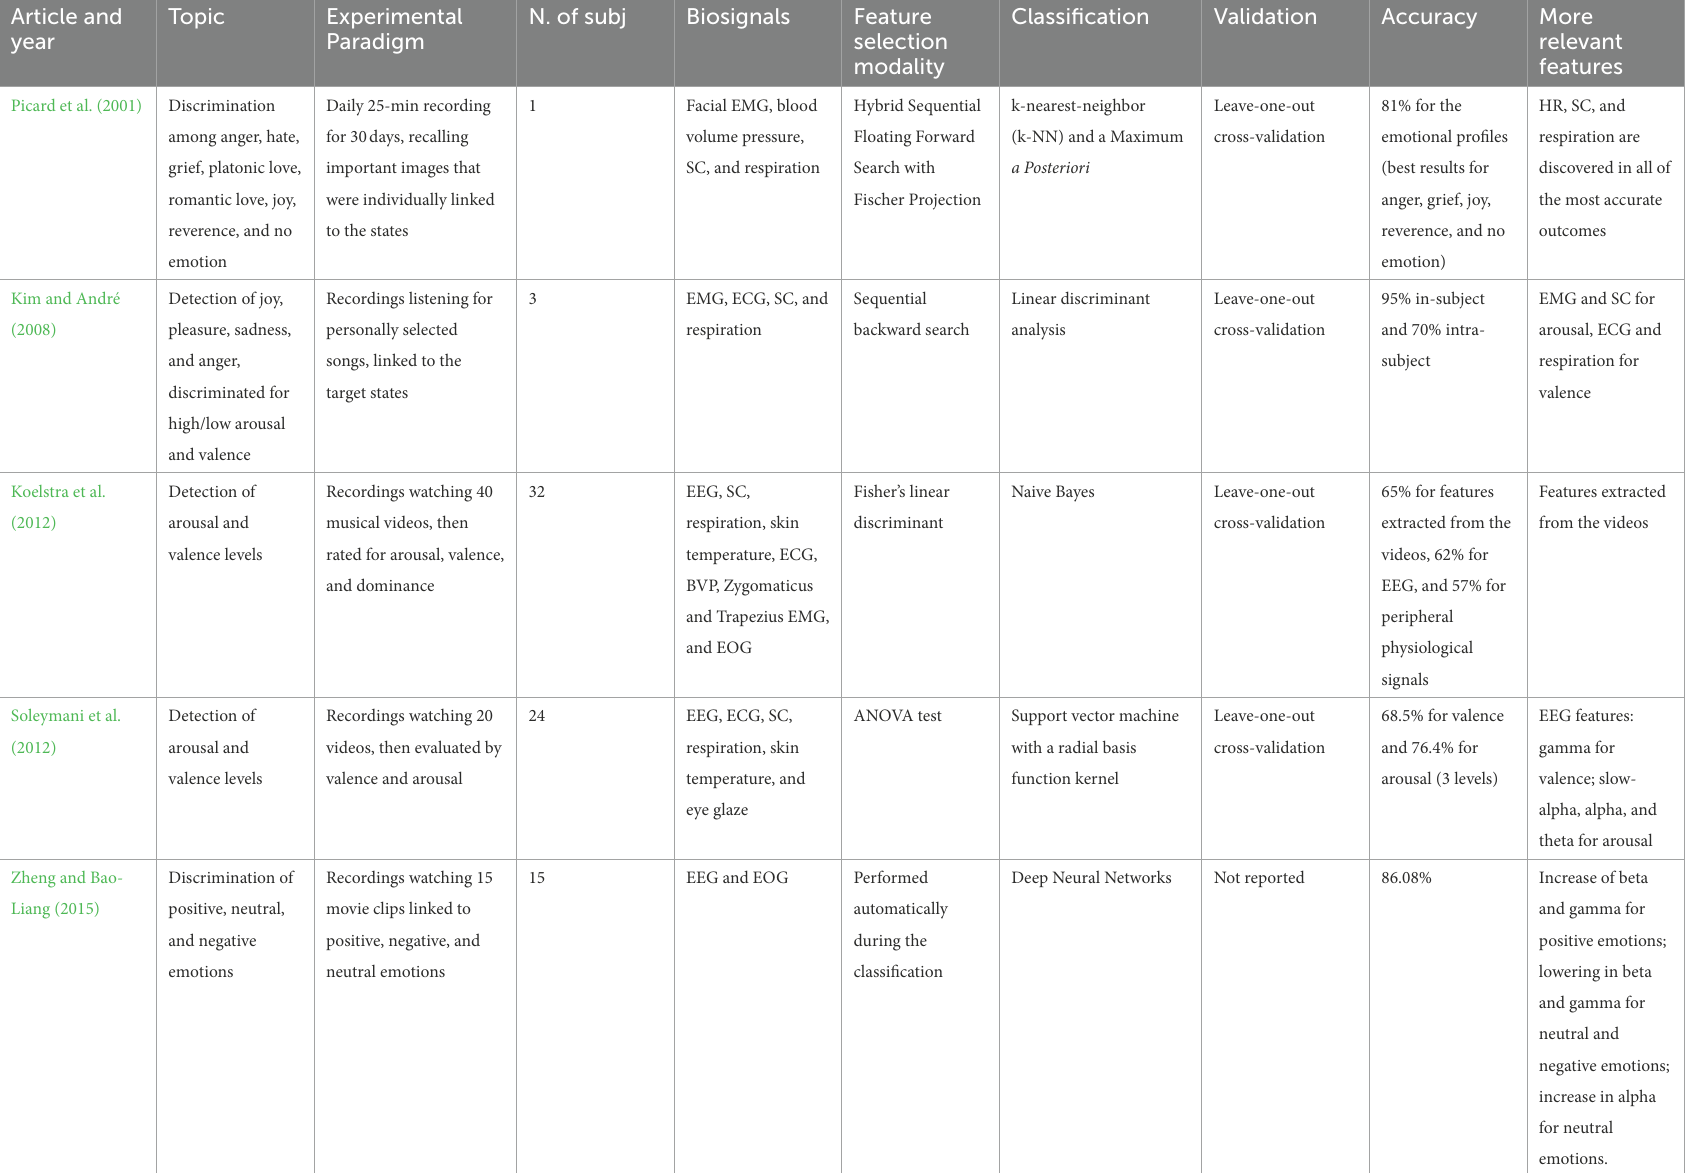
TABLE 3 The milestones research studies in Affective